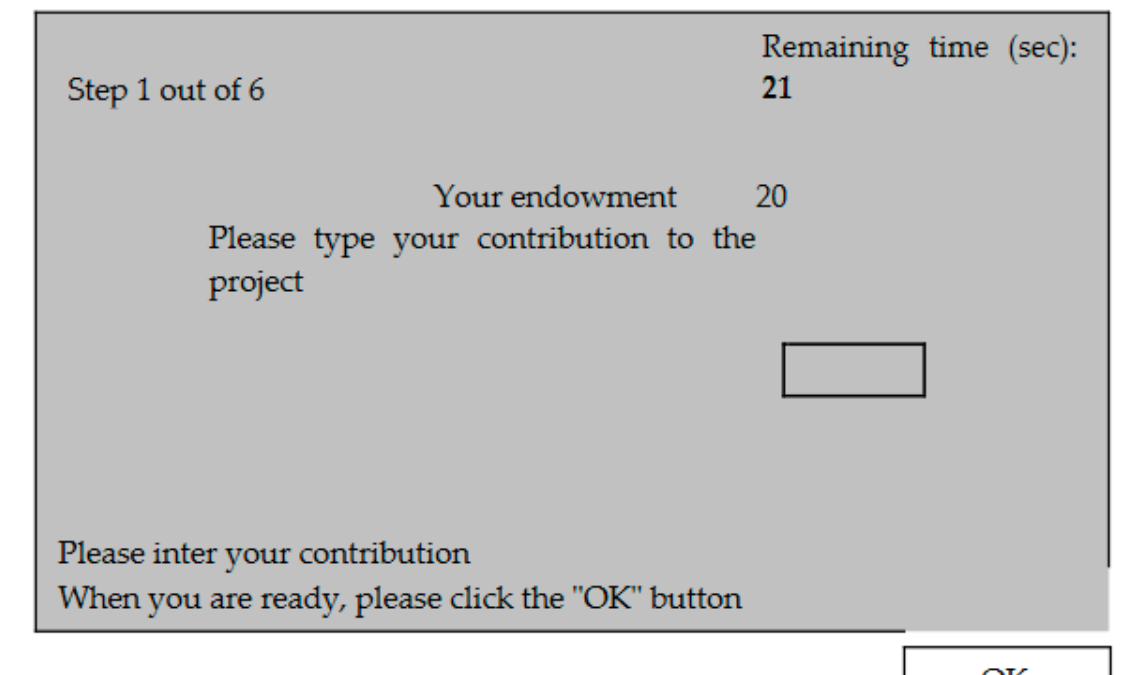
Figure A1. First screen